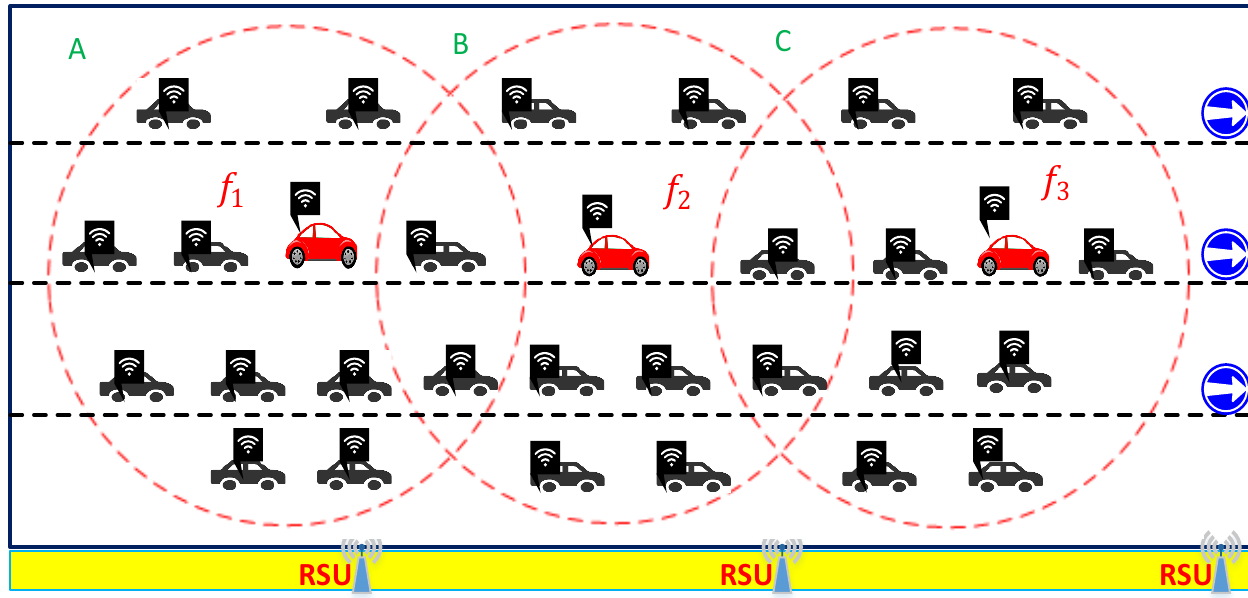
Figure 1. Four Lane Road Infrastructure for